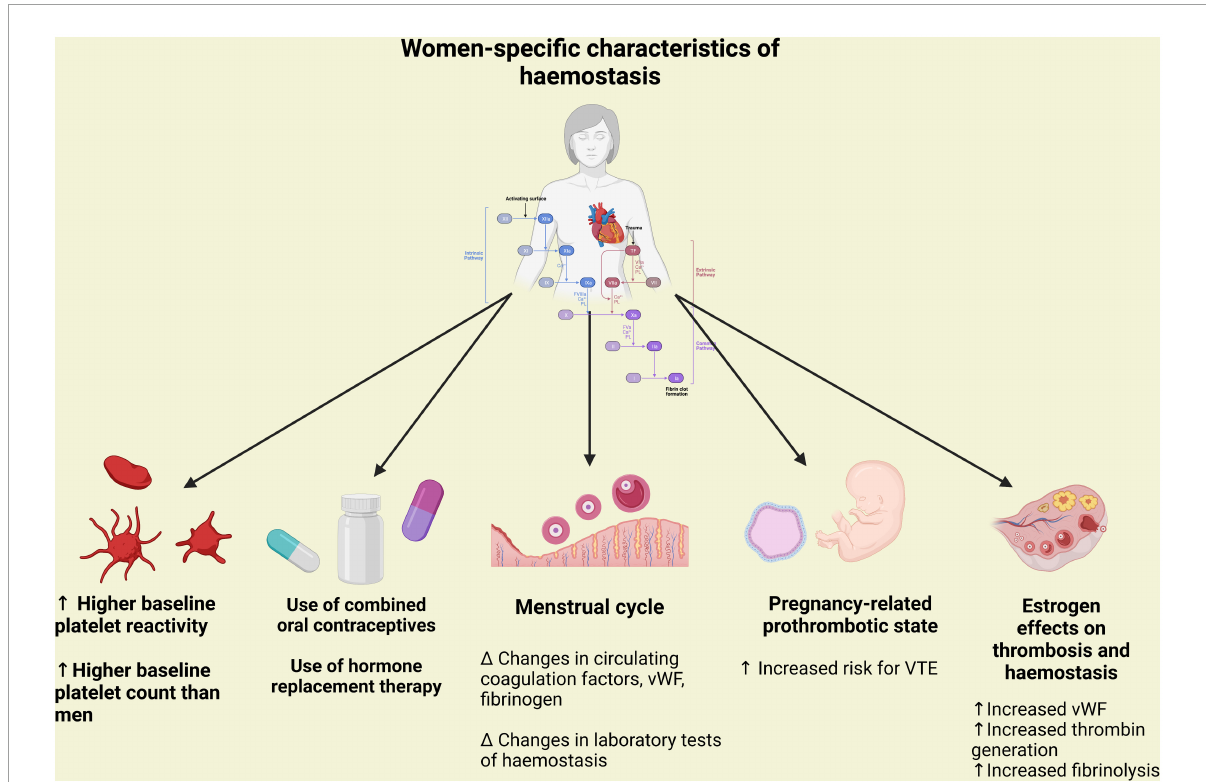
FIGURE1 Peculiarity of hemostasis in women in terms of platelet aggregation and coagulation associated with pregnancy and hormonal status. vWF, Von Willebrand factor; VTE, venous